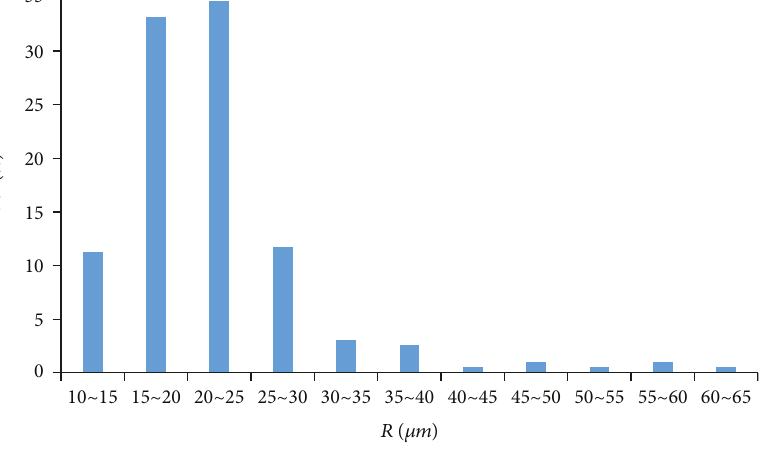
Figure 7: External radius distributions of the carbonized layer ’ s microsphere.